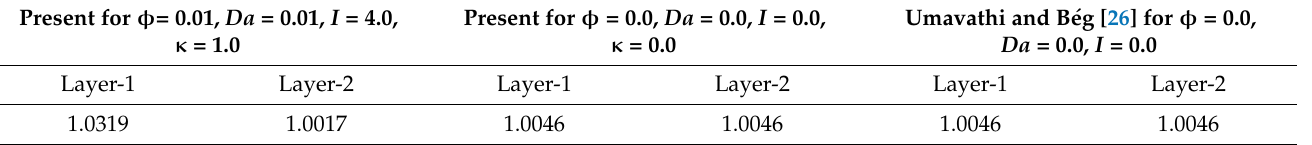
Table 2. Similarity of ( d θ / dy )